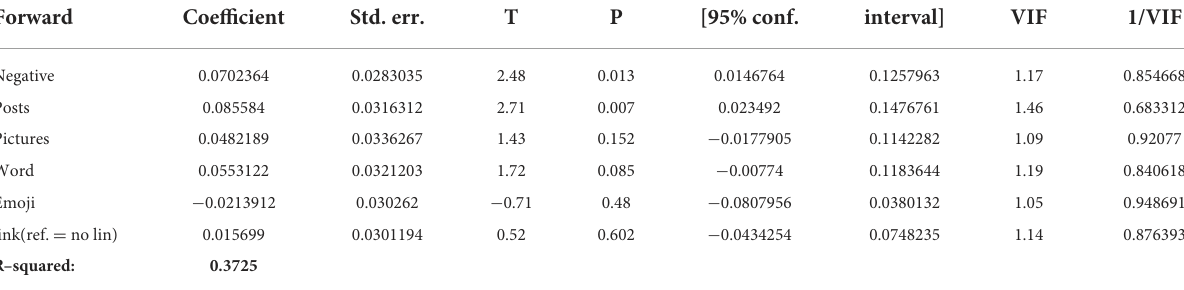
TABLE 13 Multiple linear regression results of negative sentiment regression